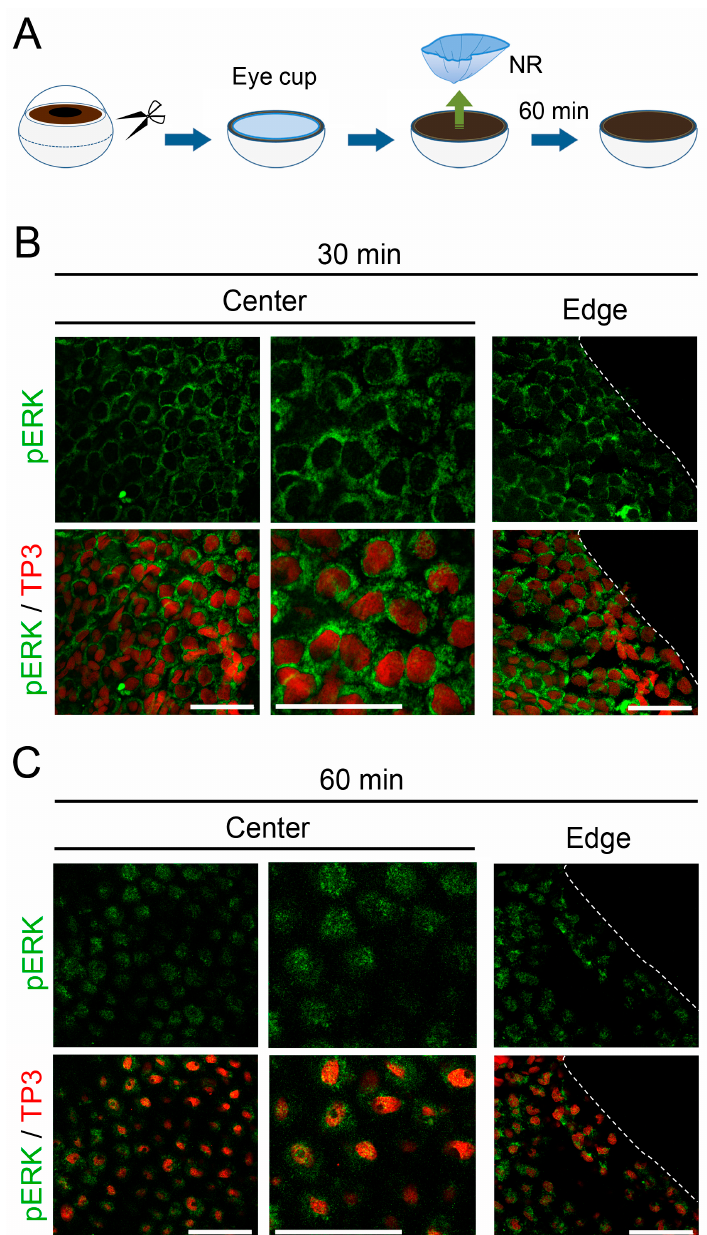
Figure 1. Retinectomy is a causal event for MEK-ERK signal reinforcement in retinal pigment epithelium (RPE) cells. ( A ) Schematic showing retinectomy in vitro; ( B , C ) Nuclear translocation of pERK in RPE cells after retinectomy in vitro. The Center and the Edge in the RPE sheet are shown. These are representative images ( n = 3 each). Right-hand panels in the Center show magnified images of corresponding left-hand panels. TP3: nuclear stain by TO-PRO ® -3 iodide. pERK immunoreactivity (green), which was observed in the cytoplasm of most RPE cells at 30 min after retinectomy; ( B ) became distributed to the nucleus (red) in the following 30 min; ( C ) Note that in these confocal microscopic images (optical slices), RPE cell nuclei at 60 min after retinectomy seemed to be smaller than those at 30 min, because the shape of the RPE cell nuclei, which was as flat as in intact cells at 30 min after retinectomy, changed into a spheroid within 60 min. Such a change in pERK immunoreactivity was observed simultaneously and uniformly throughout the RPE sheet. Scale = 100 μ m.